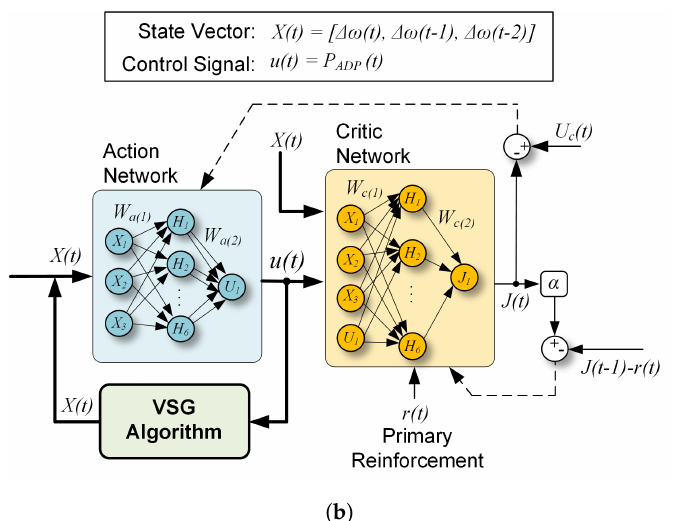
Figure 15. Modified virtual synchronous generator (VSG) using adaptive dynamic programming